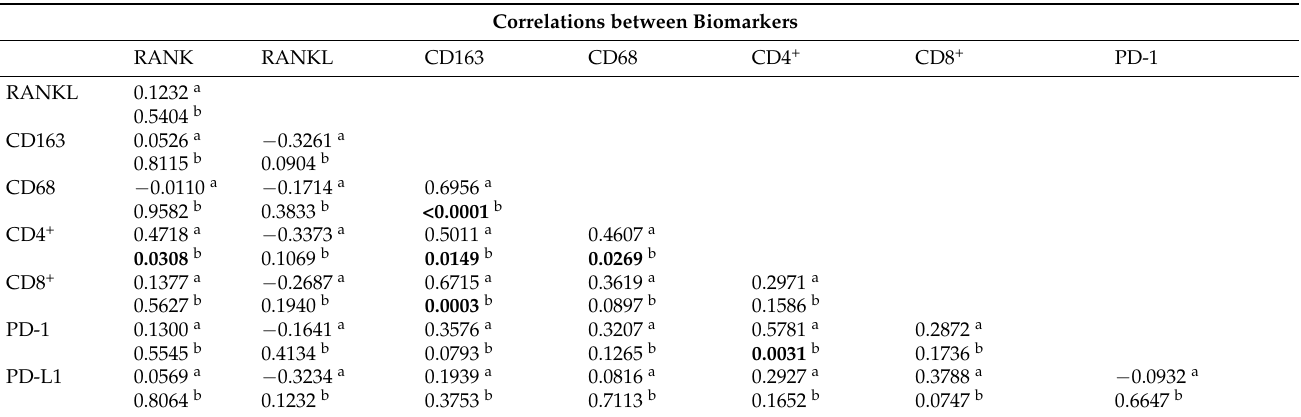
Table 2. Cont. Correlations between Biomarkers